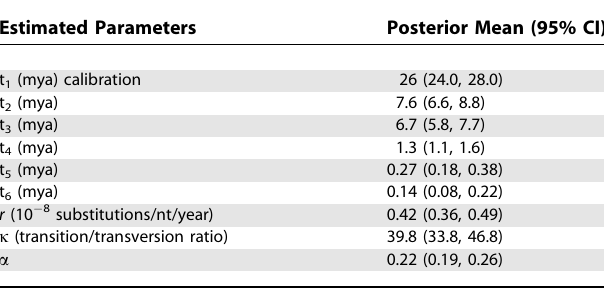
Table 2. Divergence Times Calculated Using Whole Mitochon- drial Genomes of the Four Proboscidean Species Estimated Parameters